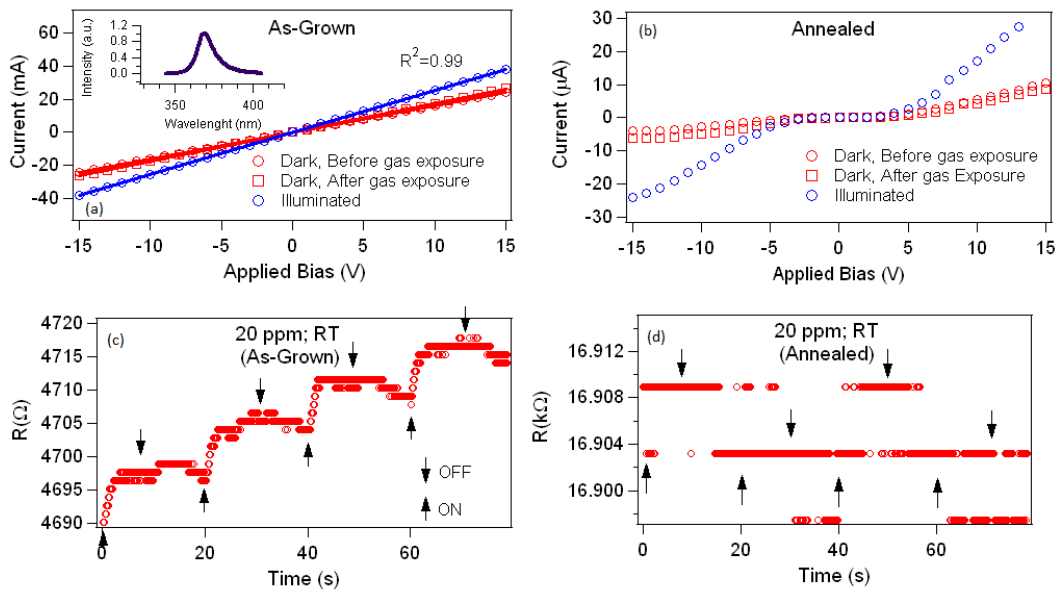
Figure 2. I–V curves under dark and UV-illuminated conditions of ( a ) as-grown and ( b ) thermally annealed ZnO-coated nanospring sensors in air. Inset of Figure 2a is the spectrum of the UV light that was used to illuminate the sensor. The solid line indicates the linear fitting. The linear feature of the I–V curves in the as-grown ZnO-coated nanospring sensor indicates an Ohmic contact, while the non-linear nature of the curve after thermal annealing indicates a Schottky-like contact. The nature of contacts is preserved after gas exposure. Comparison between the response of the ( c ) as-grown and ( d ) annealed nanospring sensor when exposed to 20 parts per million of the target gas analyte.